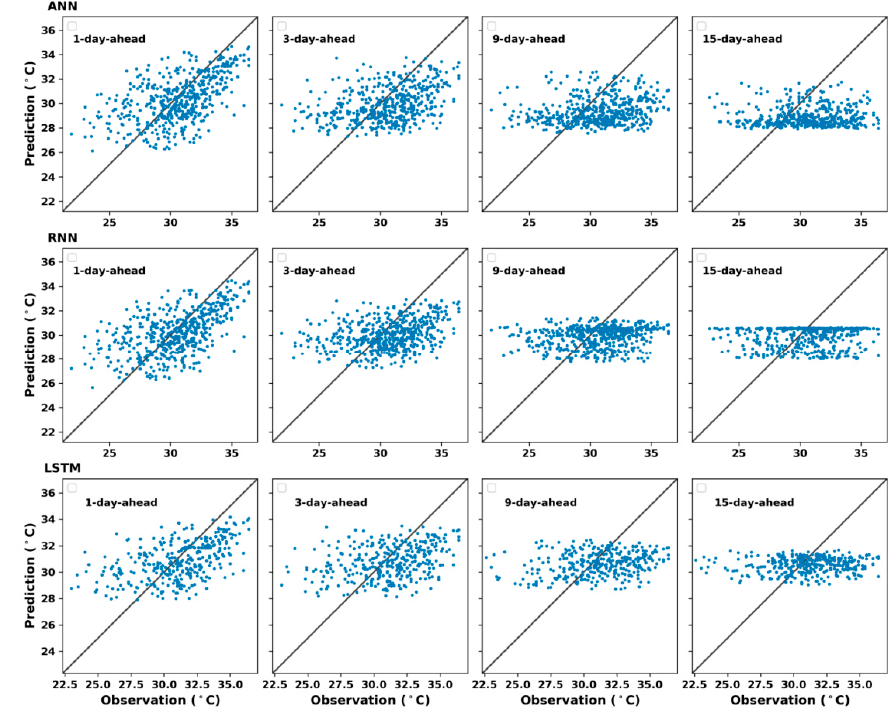
Figure 13. Prediction of k days ahead using ANN ( top ), RNN ( middle ), and LSTM ( bottom ) models for summer, k = 1,3,9,15.